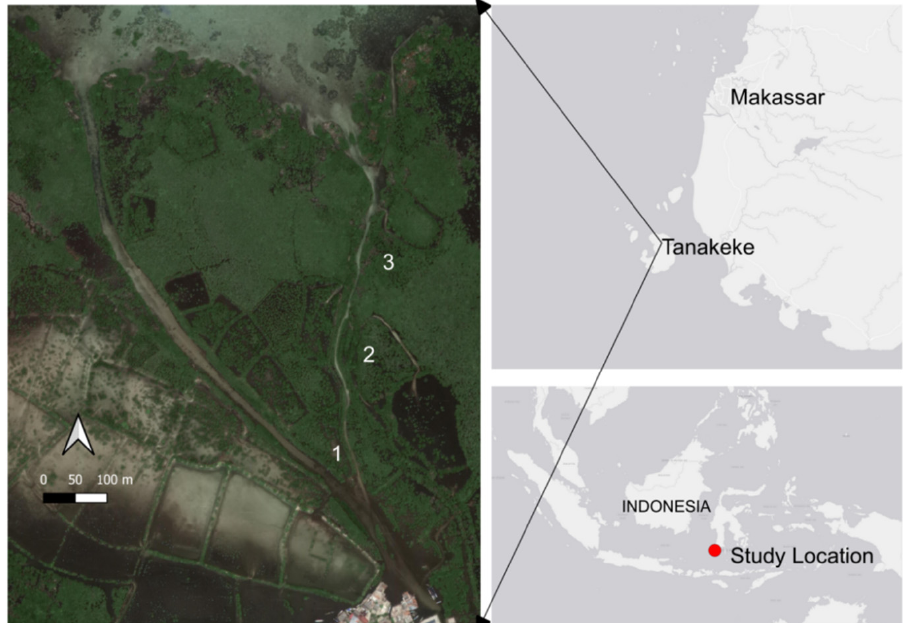
Figure 1. Study locations and the distribution of sampling sites (1–3) plotted using Google Earth imagery, depicting the landscape of aquaculture ponds and mangroves with two creeks splitting the landscapes. White and brown colour spotted by green (left section of figure) depicts recently abandoned ponds; patches of green colour surrounded by a brown line depicts long abandoned ponds; and the green-coloured blocks show undisturbed mangrove vegetation.